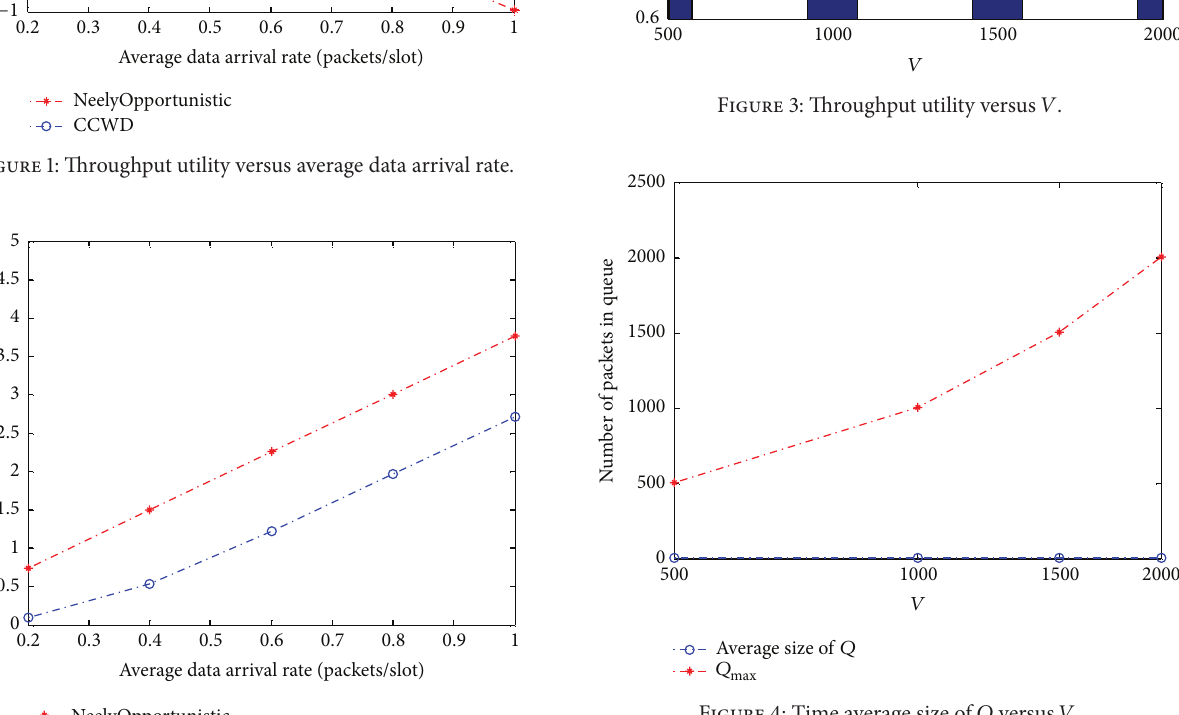
Figure 4: Time average size of 𝑄 versus 𝑉